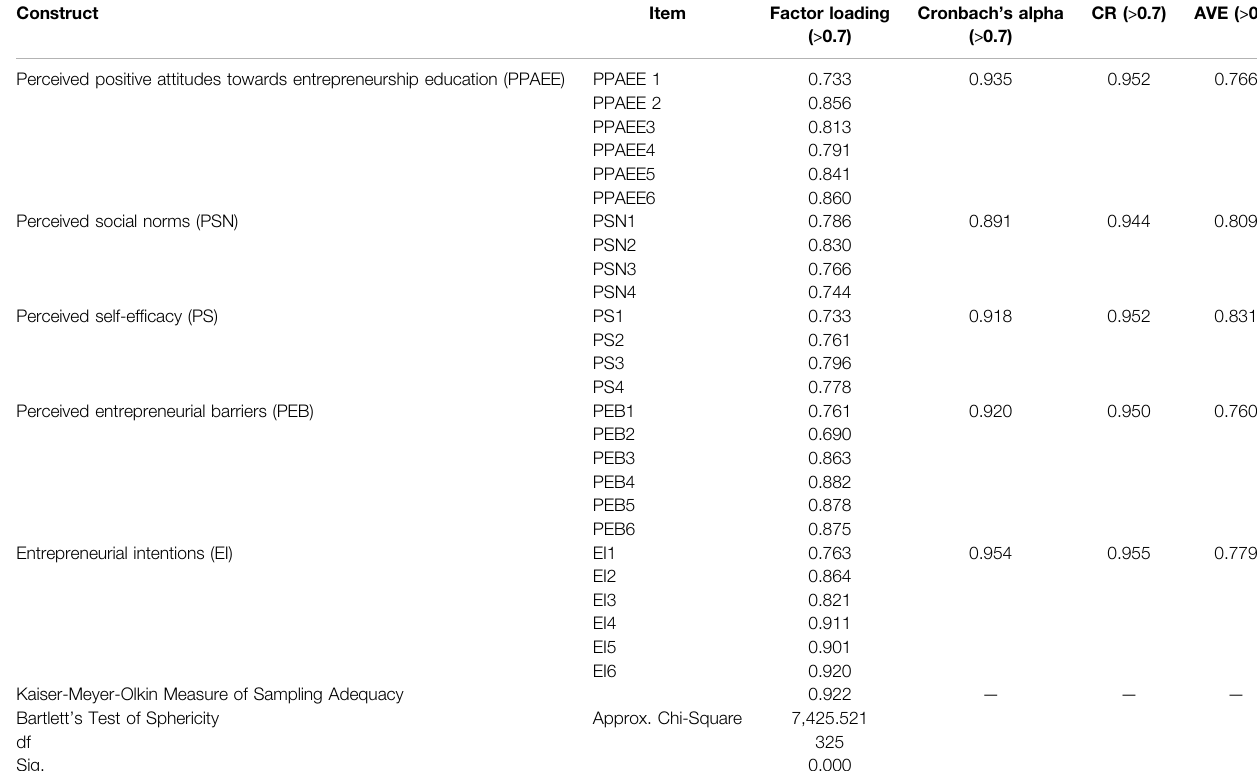
TABLE 3 | Validity and reliability evidence. Construct